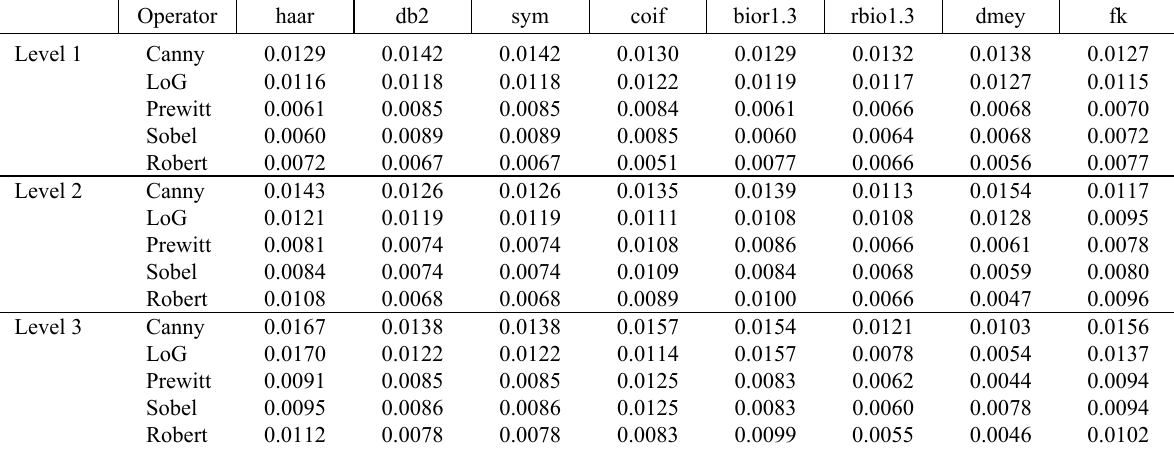
Table 9. F-measure values for different edge detection operators and wavelet transformations for an image with MD